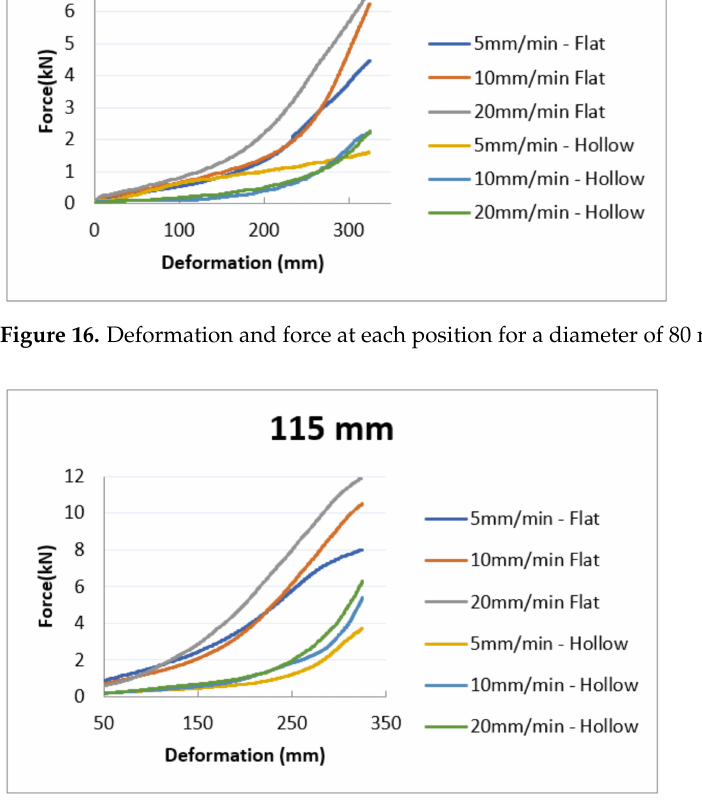
Figure 17. Deformation and force at each position for a diameter of 115